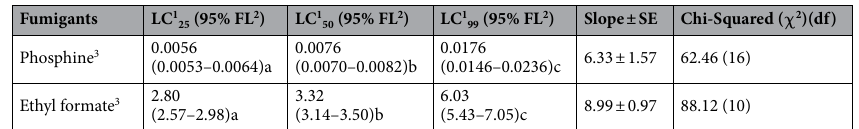
Table 1. Three days post fumigation lethal concentration (LC) of ethyl formate and phosphine against adult C. chinensis for a fumigation period of 24 h at 25 ± 3 °C and 60–70% RH. 1 mgL -1 , 2 Fiducial limits, 3 Sub-lethal concentrations calculated from 3-d post fumigation end-point mortality data. Differences in small cases following the LC (95% FL) values along the rows are for significant differences if the 95% confidence intervals did not overlap. The data for EF in Table 1 were referred from Chiluwal et al. 13 .